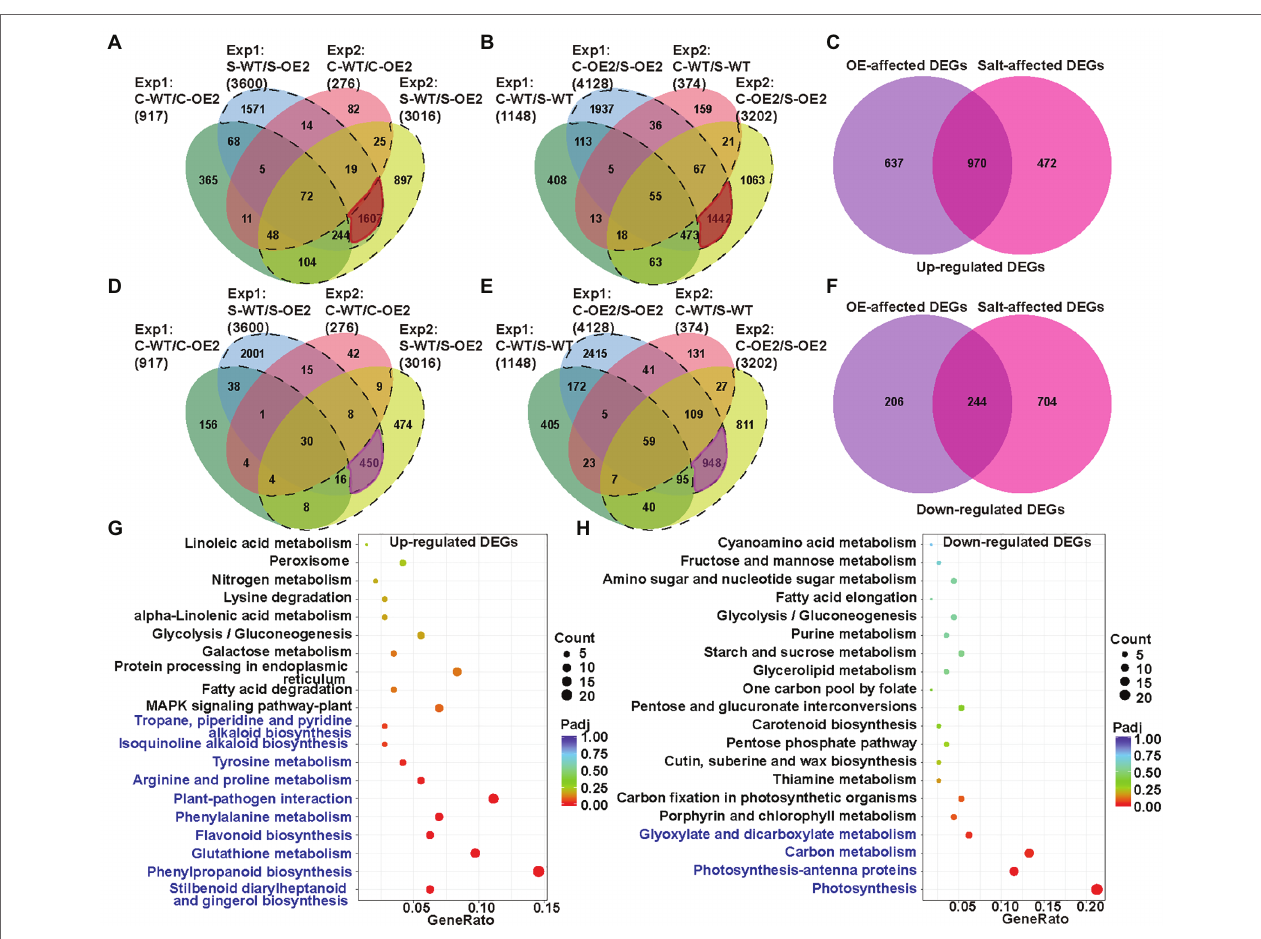
FIGURE 8 | The analysis of leaf transcriptome data of WT and the NtCBL5A -overexpressing line (OE-2) at 4 DAT. (A) Venn diagram with four up-regulated gene sets: Experiment 1 (Exp1)-C-WT/C-OE2, Exp 1-S-WT/S-OE2, Exp 2-C-WT/C-OE2, and Exp 2-S-WT/S-OE2. (B) Venn diagram with four upregulated gene sets: Exp1-C-WT/S-WT, Exp 1-C-OE2/S-OE2, Exp 2-C-WT/S-WT, and Exp 2-C-OE2/S-OE2. (C) Venn diagram with two sets: OE-affected upregulated differentially expressed genes (DEGs) and Salt-affected upregulated DEGs. (D) Venn diagram with four downregulated gene sets: Exp 1-C-WT/C-OE2, Exp 1-S-WT/S-OE2, Exp 2-C-WT/C-OE2, and Exp 2-S-WT/S-OE2. (E) Venn diagram with four downregulated gene sets: Exp 1-C-WT/S-WT, Exp 1-C-OE2/S-OE2, Exp 2-C-WT/S-WT, and Exp 2-C-OE2/S-OE2. (F) Venn diagram with two sets: OE-affected down-regulated DEGs and Salt-affected downregulated DEGs. (G,H) Kyoto encyclopedia of genes and genomes (KEGG) enrichment of upregulated genes and downregulated genes. The pathways labeled in blue were significantly enriched pathways. Count: the number of DEGs, bigger circle means more DEGs number; GeneRatio: the number of DEGs/the total number of genes in this pathway; padj: p , padj < 0.05 means significant difference, redder color means greater significance. The raw data of RNA-seq can be found in GEO data repository with the accession number GSE181164, in which samples were named as C-WT-1, S-WT-1, C-OE2-1, S-OE2-1, C-WT-2, S-WT-2, C-OE2-2, and S-OE2-2. “C” refers to “Control,” “S” refers to “Salt,” “WT” refers to “wild-type,” “OE2” refers to the OE2 line of NtCBL5A -overexpressing lines, “1” refers to “Experiment 1,” and “2” refers to “Experiment